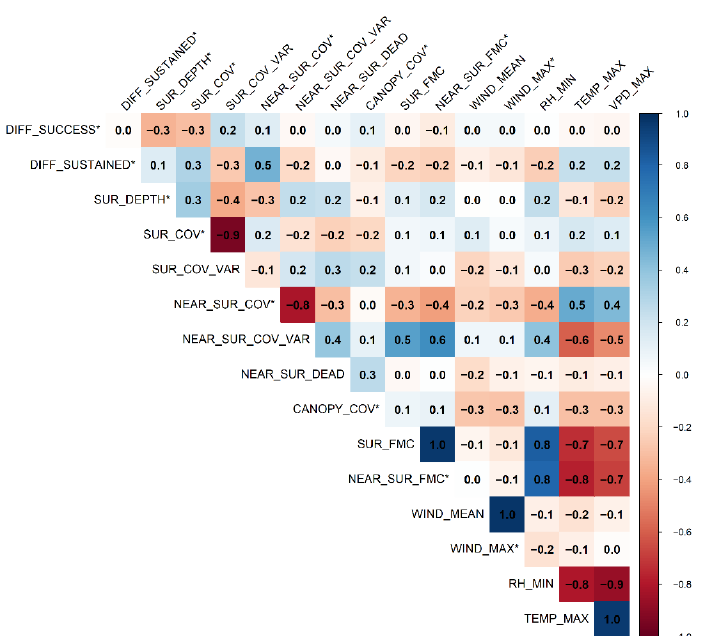
Figure A1. Correlogram showing the strength of Pearman’s correlations between the difference (i.e., ignition result (field)—ignition result (laboratory)) and potential predictor variables. Positive correlations are displayed in blue and negative correlations in red. Colour intensity is proportional to the correlation coefficient. Variables with * were used in final analysis. Variables: DIFF_SUCCESS = difference in proportion of successful ignitions, DIFF_SUSTAINED = difference in proportion of sustained ignitions, SUR_DEPTH = litter-bed depth, SUR_COV = litter-bed cover, SUR_COV_VAR = coefficient of variation in litter-bed cover, NEAR_SUR_COV = near-surface cover, NEAR_SUR_COV_VAR = coefficient of variation in near-surface cover, NEAR_SUR_DEAD = near-surface dead fraction, CANOPY_COV = canopy cover, SUR_FMC = surface litter moisture content (bulk sample), NEAR_SUR_FMC = near-surface dead fuel moisture content (bulk sample), WIND_MEAN = average wind speed, WIND_MAX = maximum wind speed, RH_MIN = minimum relative humidity, TEMP_MAX = maximum temperature, and VPD_MAX = maximum vapour pressure deficit.